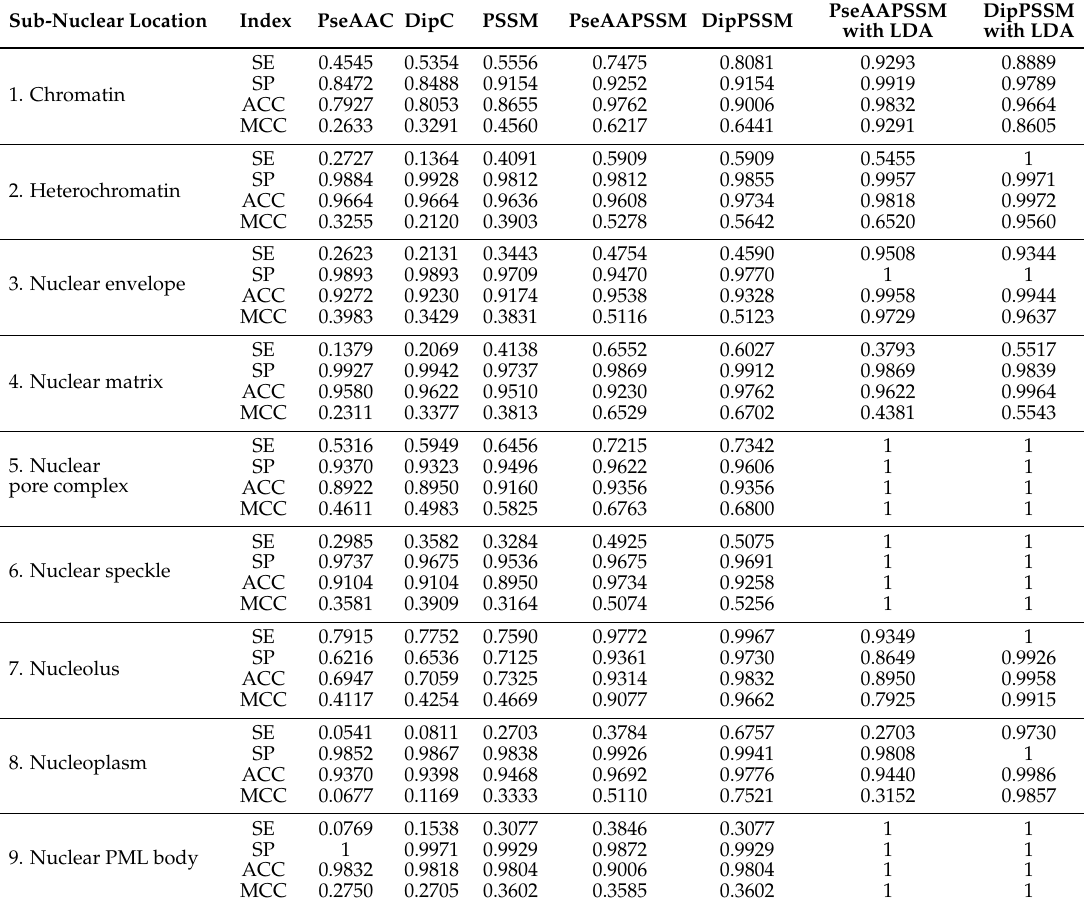
Table 6. Performance of various representations on Dataset 1.